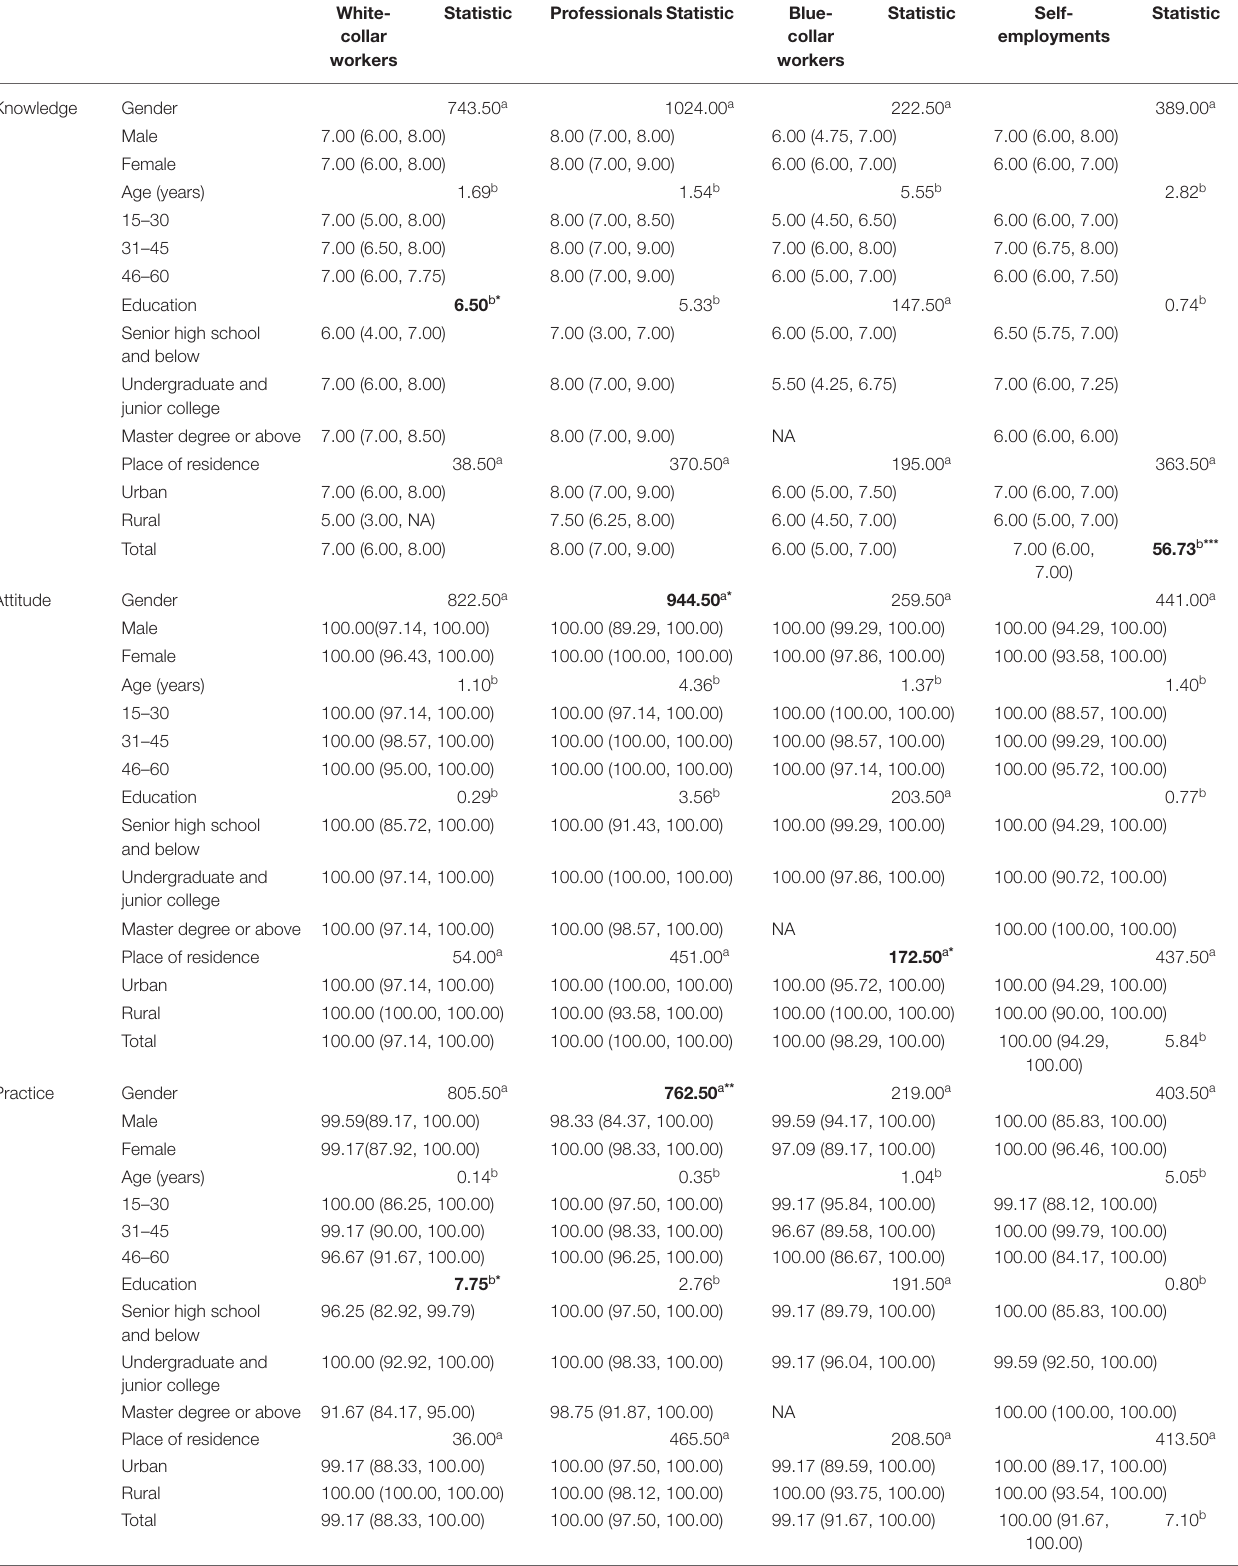
a outcomes of Mann-Whitney U test, b outcomes of Kruskal-Wallis H test. * P < 0.05, ** P < 0.01, *** P < 0.001. Bold indicates that the results are statistically